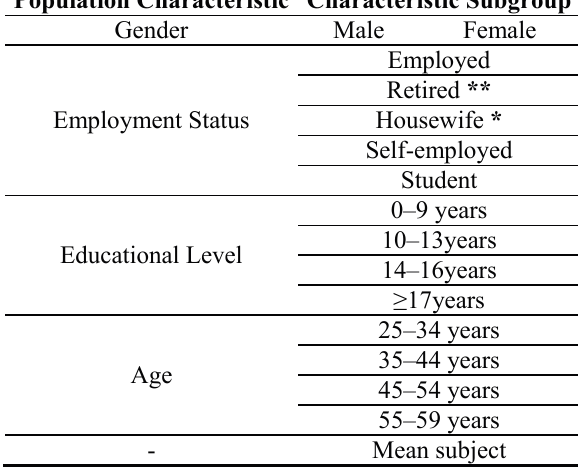
Table 1. Subpopulations defined as a function of gender and segregated by employment status, educational level or age.